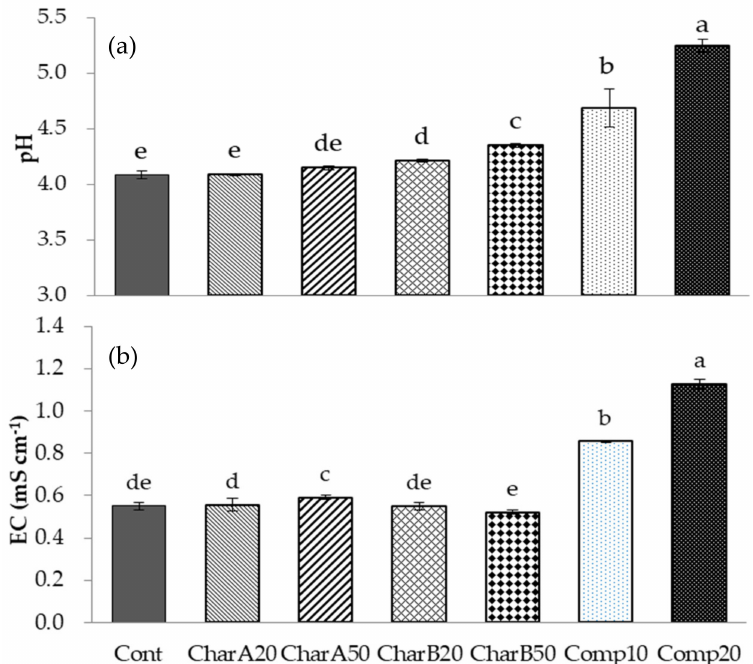
Figure 1. Soil pH ( a ) and electrical conductivity (EC) ( b ) after 45 days of incubation in response to di ff erent amendments. The bar on the columns indicates the standard deviation of three replicates (n = 3) for each treatment. Columns with di ff erent letters indicate a significant di ff erence ( p < 0.05) among treatments. Cont, soil without amendment; CharA20, soil + 20 g kg − 1 of Biochar A; CharA50, soil + 50 g kg − 1 of Biochar A; CharB20, soil + 20 g kg − 1 of Biochar B; CharB50, soil + 50 g kg − 1 of Biochar B; Comp10, soil + 10 g kg − 1 of compost; Comp20, soil + 20 g kg − 1 of